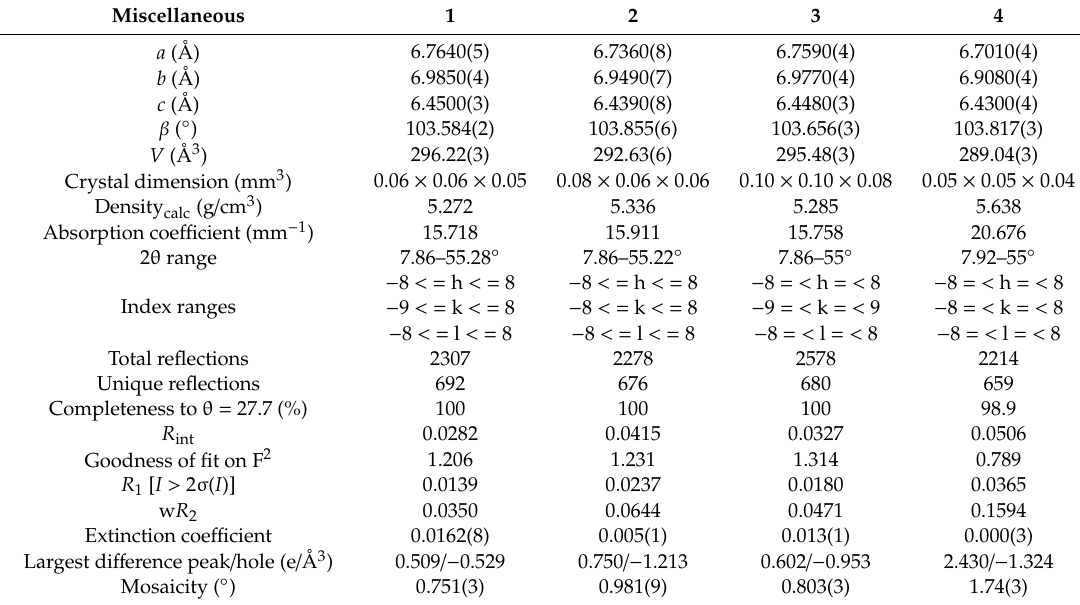
Table 3. Single-crystal structure refinement (single-crystal X-ray di ff raction, SCXRD) data for the four monazite § samples used in this